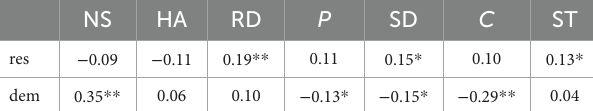
TABLE 2 Correlations between personality dimensions and parenting